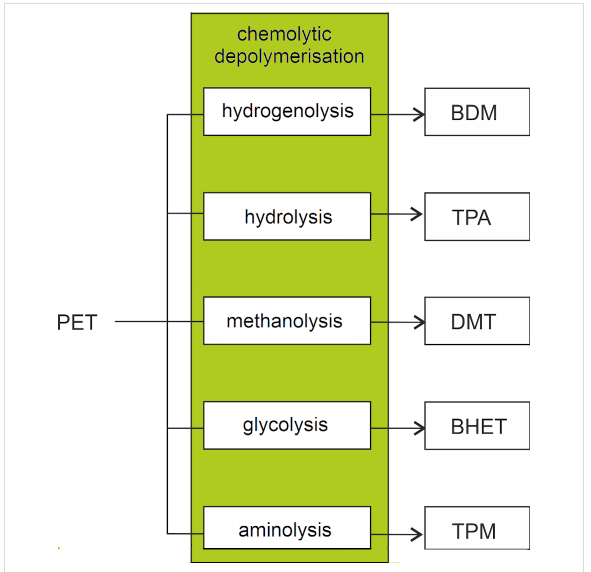
Figure 3: Main added-value monomers obtainable by catalytic depoly- merisation of PET via chemolytic